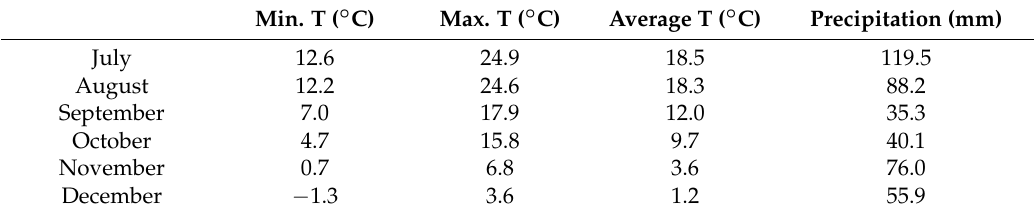
Table 1. Monthly minimum (Min.), maximum (Max.), average temperature (T) and precipitation in Southwestern Germany from July until December 2017. Min. T ( ◦ C) Max. T ( ◦ C) Average T ( ◦ C) Precipitation (mm)